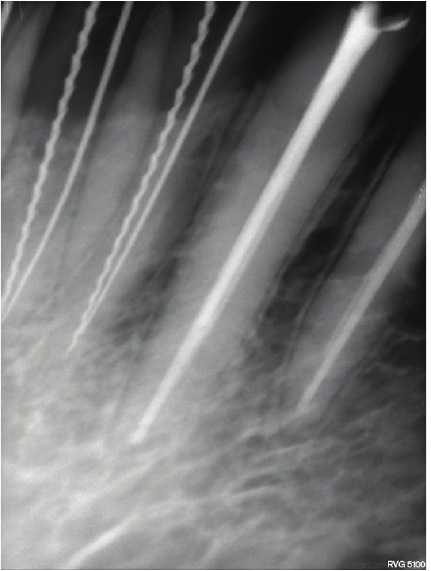
Figure 4: Radiograph showing two different instruments (“H” file and Reamer) in two canals in 41 and